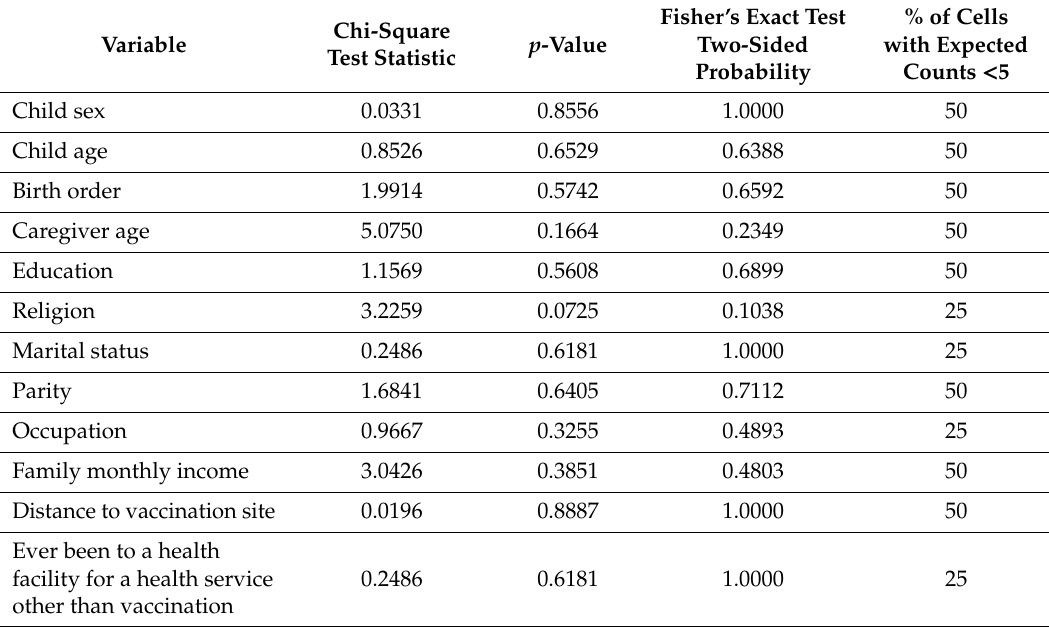
Table 7. Chi-square statistics of sociodemographic variables and whether the maternal recall demonstrates accurate vaccination status or false positive or false